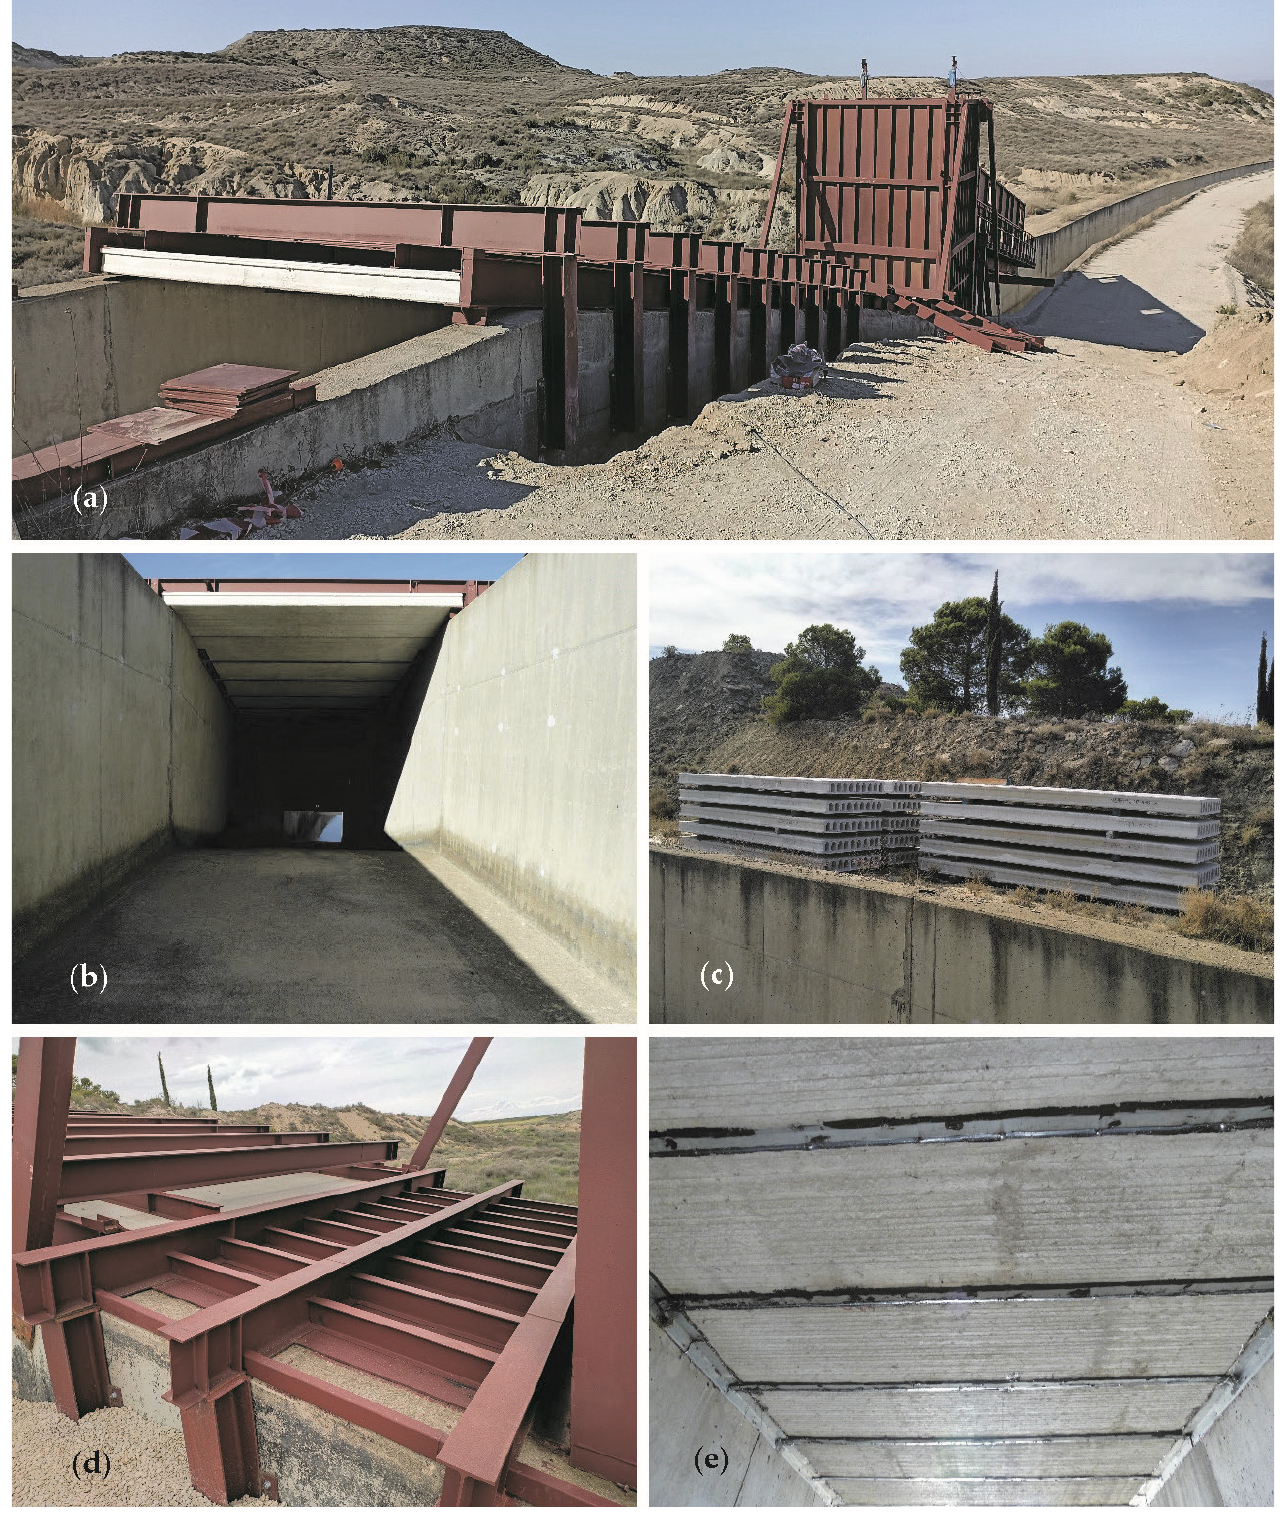
Figure 4. ( a ) View of HEFLR from the right bank of the auxiliary channel. ( b ) View of the interior of the auxiliary channel from upstream of the pressure channel. ( c ) Storage of the honeycomb slabs used to cover the pressure channel. ( d ) Metallic frames used to support the honeycomb slabs of the pressure channel and the metallic plates on the connection to the tower supply. ( e ) Detail of the sealing between the slabs and the channel walls (view from inside the pressure channel).